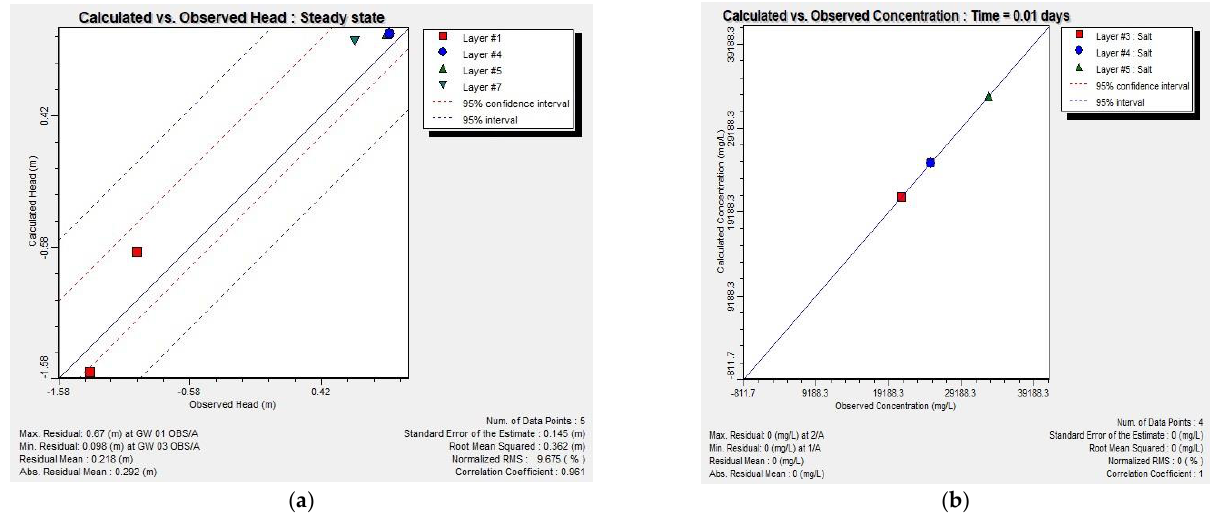
Figure 9. Calculated groundwater levels in 2018.